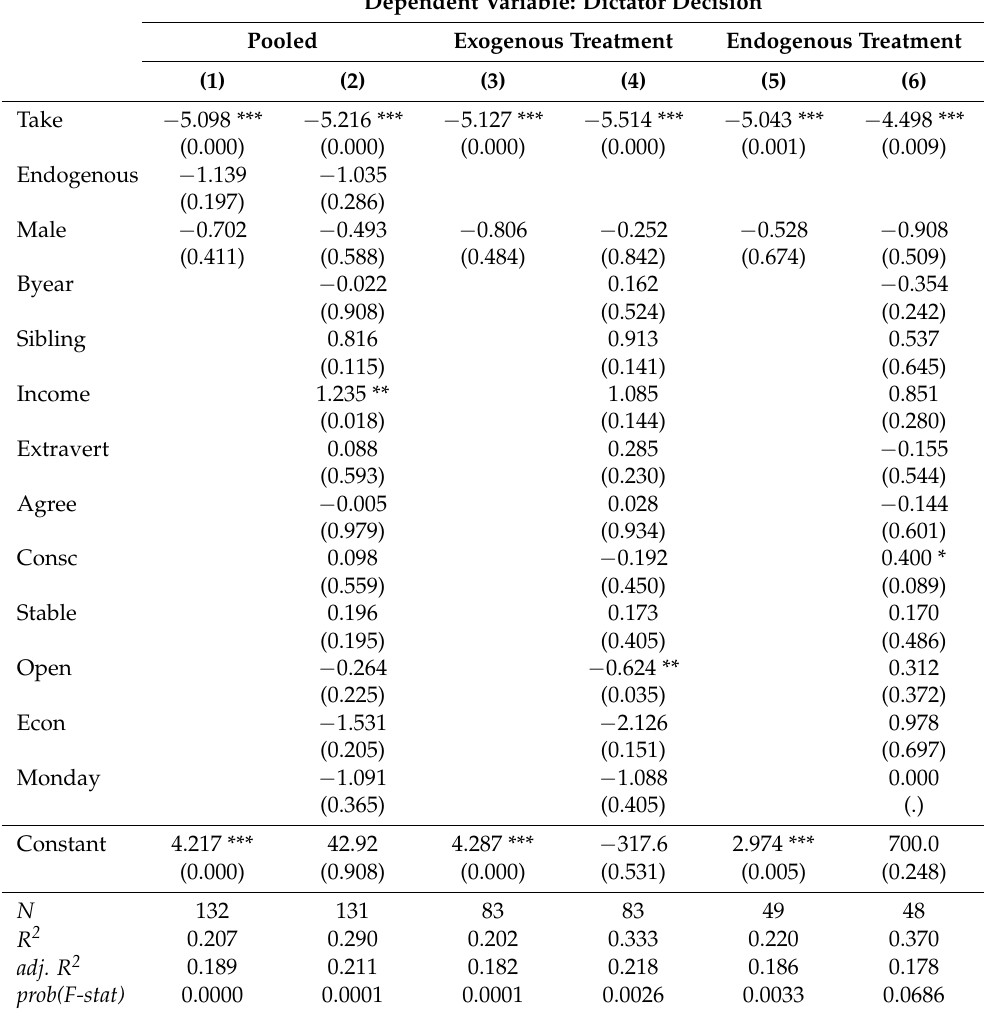
Table 2. OLS results for giving in dictator and taking